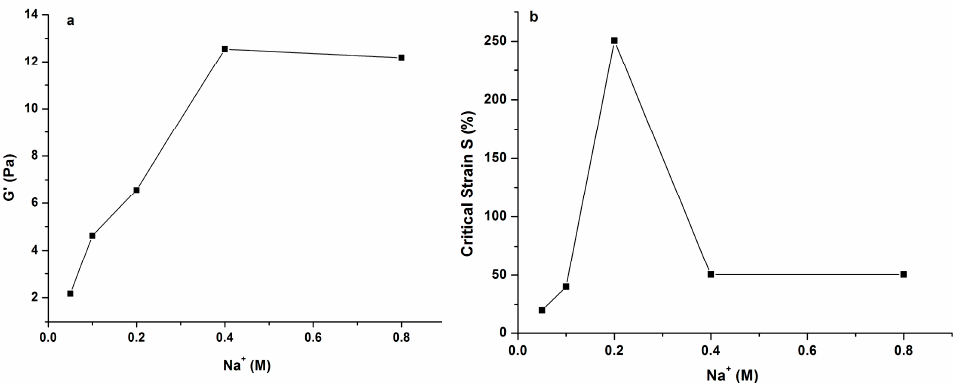
Figure 6. Variation of elastic modulus (G ′ ) ( a ) and critical strain (S) ( b ) of 1.0% PLAP added with 0.2 M Na + .